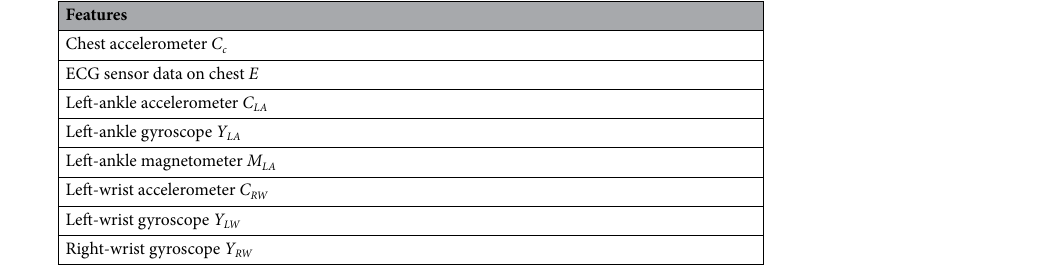
Table 1. Features from MHEALTH